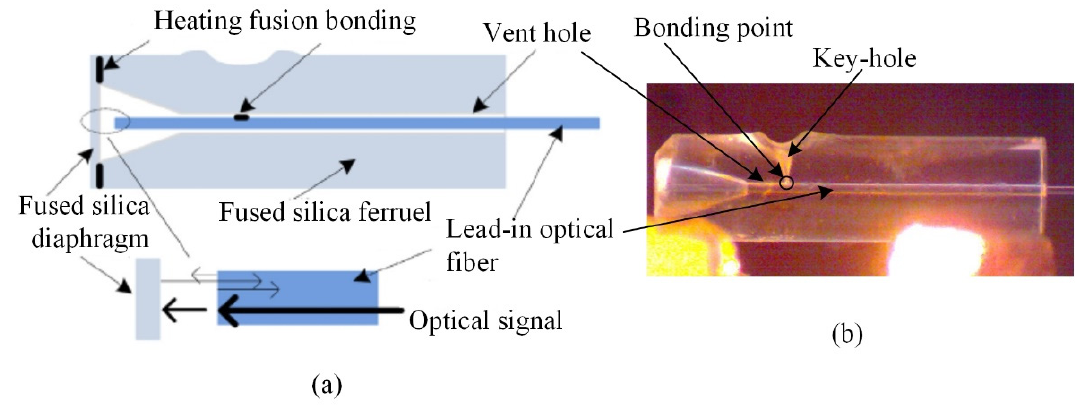
Figure 1. Structure of the sensor. ( a ) schematic diagram, ( b ) physical photo.